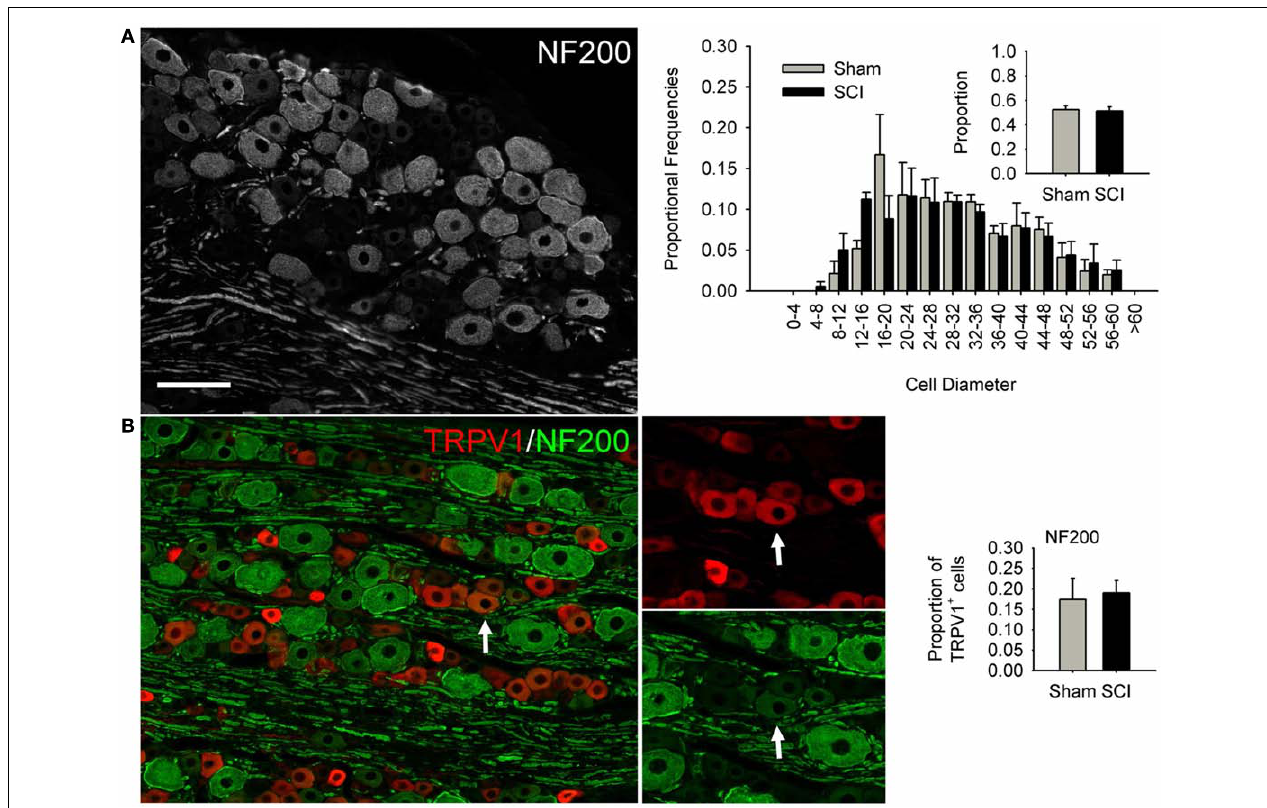
change. (B) Hypertrophy ofTRPV1-expressing DRG neurons was not accompanied by increased co-localization ofTRPV1 and NF200. Ganglia were harvested 3months after sham-injury (gray) or completeT3 SCI (black). Arrow: DRG neuron immunopositive for bothTRPV1 and NF200. Scale bar = 70 µ